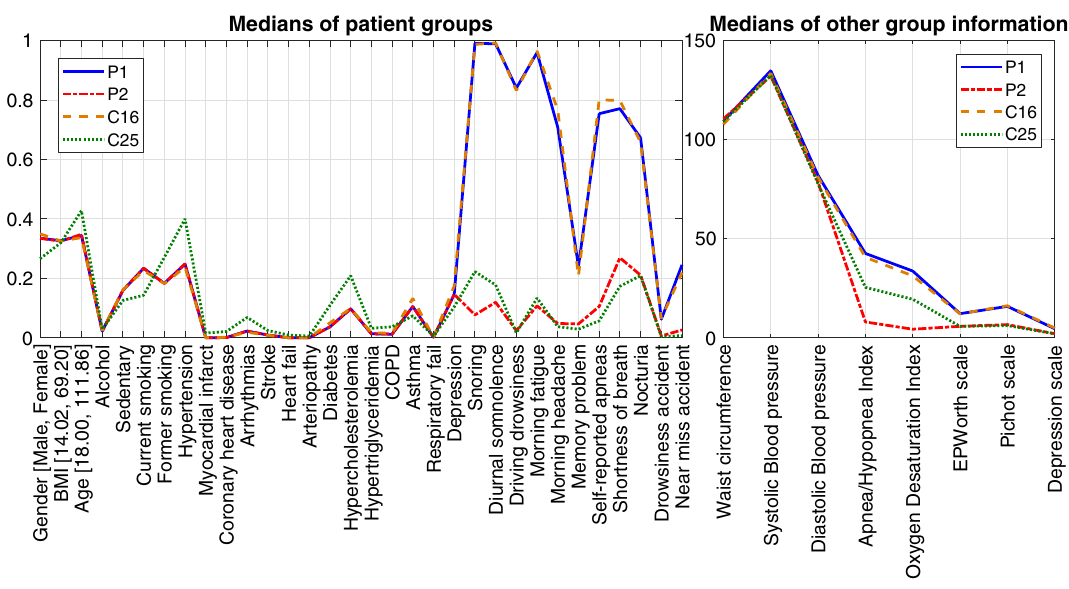
Fig. 19 The set P of patients that changes from the group A (most severe OSA symptoms) in Snapshot 1 to the group C (least severe OSA symp- toms) in Snapshot 2. Here P i means the set of patients P in Snapshot S i and C ij means cluster C j in Snapshot S